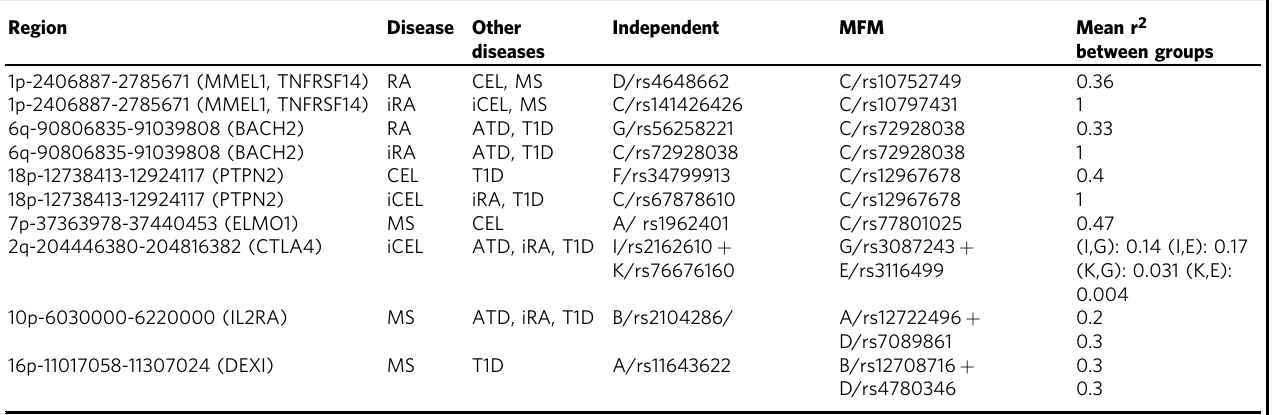
Table 2 Regions with con fl icting models chosen by independent disease analysis and MFM Region Disease Other diseases between groups